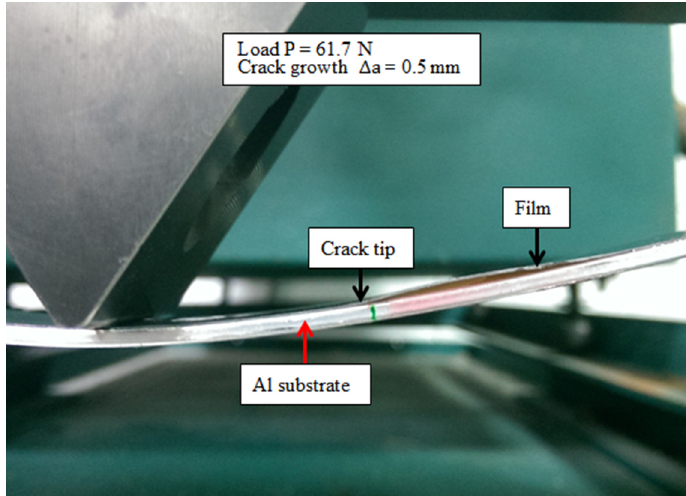
Figure 11. Crack propagation at the critical load.